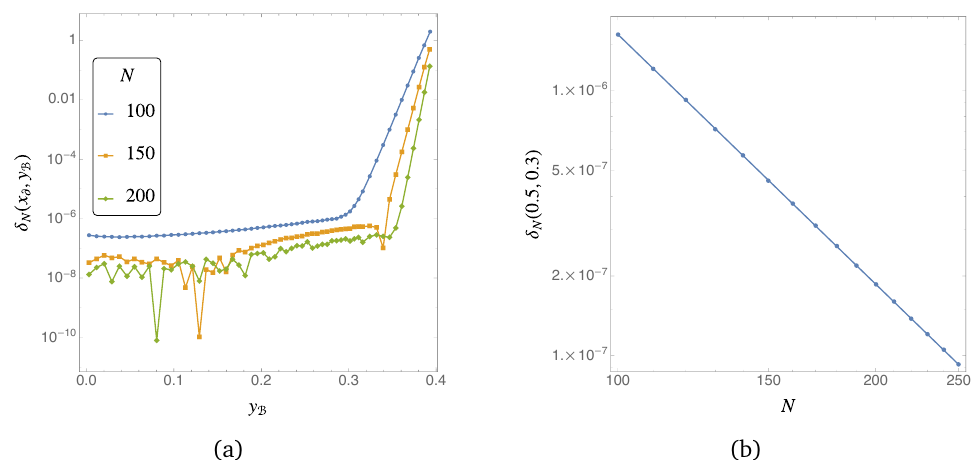
( x ) computed for several values of N labeled in the plot. Figure 7: (a) Plot of δ ∂ , y B N For y B ∈ [ 0.0028 ( 7 ) ,0.35379 ( 9 )] the relative error is smaller than 10 − 6 . (b) Plot ( 0.5,0.3 ) in a log − log scale computed for several values of N . The numerical of δ N data is represented by the blue disks, and the solid blue line is a best fit curve which ( 0.5,0.3 ) ∼ N − 3.13 yields δ N